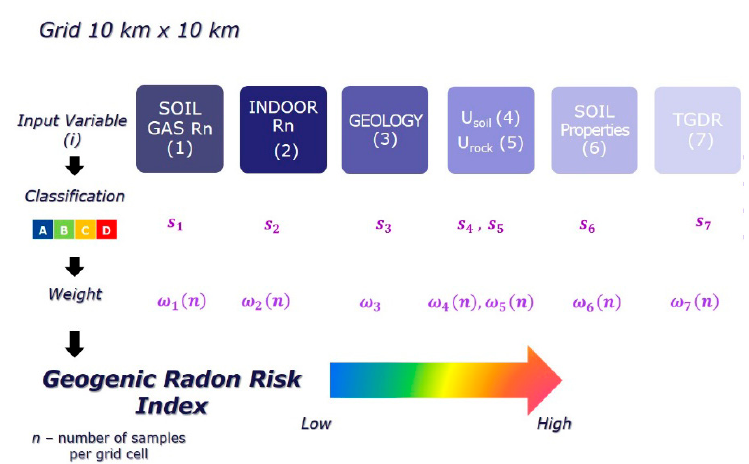
Figure 1. General workflow of multivariate classification approach to construct a geogenic radon hazard index (GRHI) [49]. TGDR—terrestrial gamma dose rate.